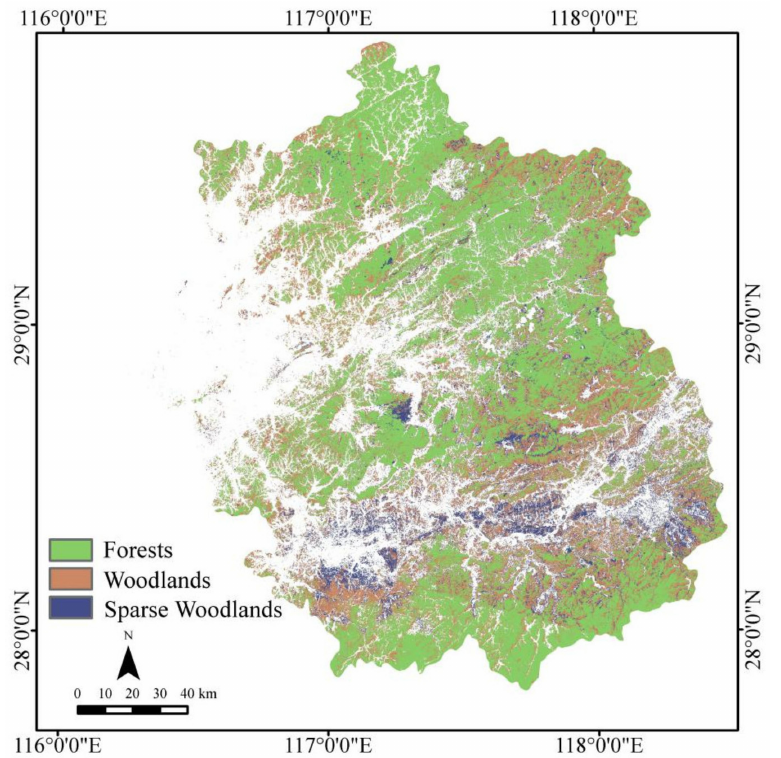
Figure 8. Woodland classification map of northeast Jiangxi. Note: Forests where CC > 60%—CC H ,